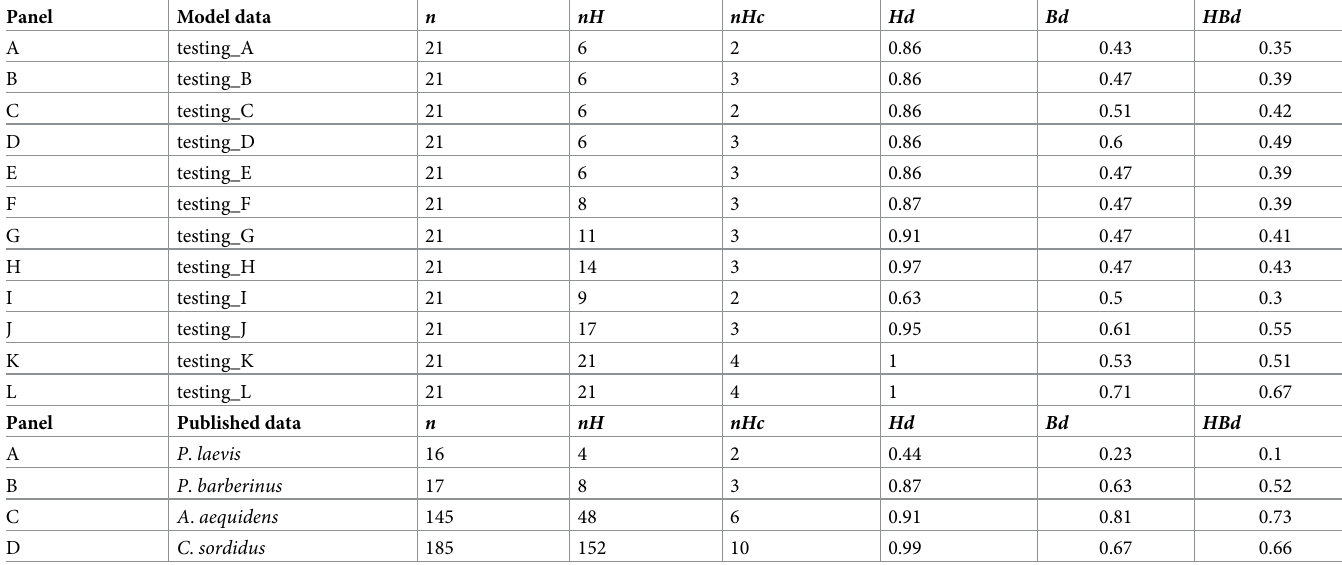
Columns from left to right: Panel and names of datasets corresponding to Figs 1 and 2, number of individuals ( n ), number of haplotypes ( nH ), number of haplotype classes ( nHc ), haplotype diversity ( Hd ), branch diversity ( Bd ), and haplotype network branch diversity ( HBd